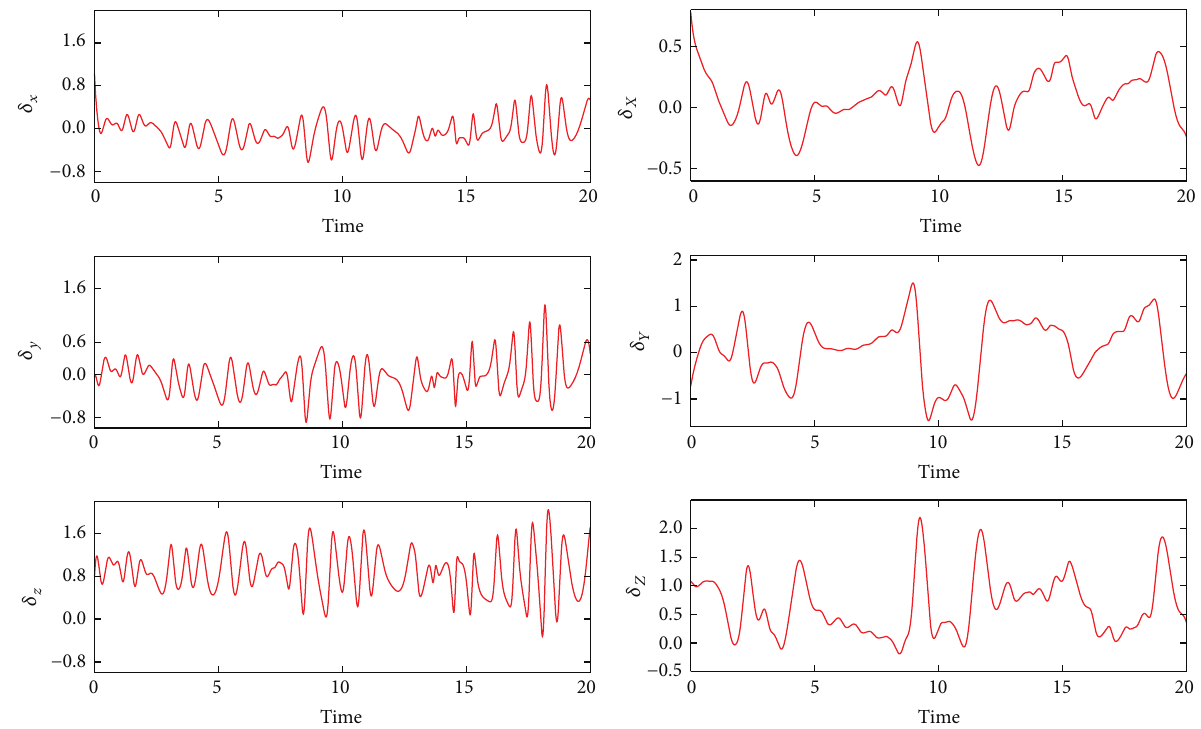
Figure 14: Difference between variables that correspond to the original trajectory and pseudoorbit for 𝑐 0 = 0.8 .